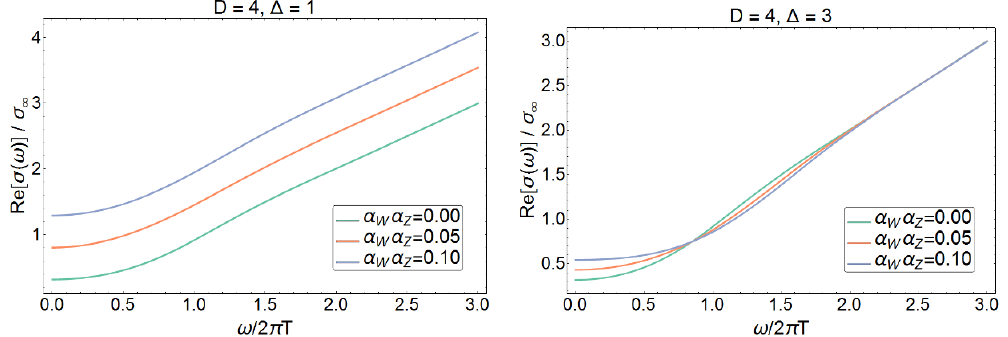
Figure 5 . The real part of the AC conductivity for D = 4 and (cid:1) = 1 (left) and (cid:1) = 3 (right), in the critical theory ( h = 0), for various choices of coupling constants (cid:11) W (cid:11) Z . At large ! , Re( (cid:27) ( ! )) ~ (cid:27) 1 ! , with (cid:27) 1 = (cid:25) given in 2 C JJ